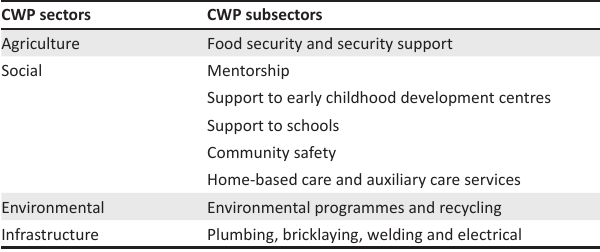
TABLE 2: Sectors and subsectors for community work programme participation. CWP sectors